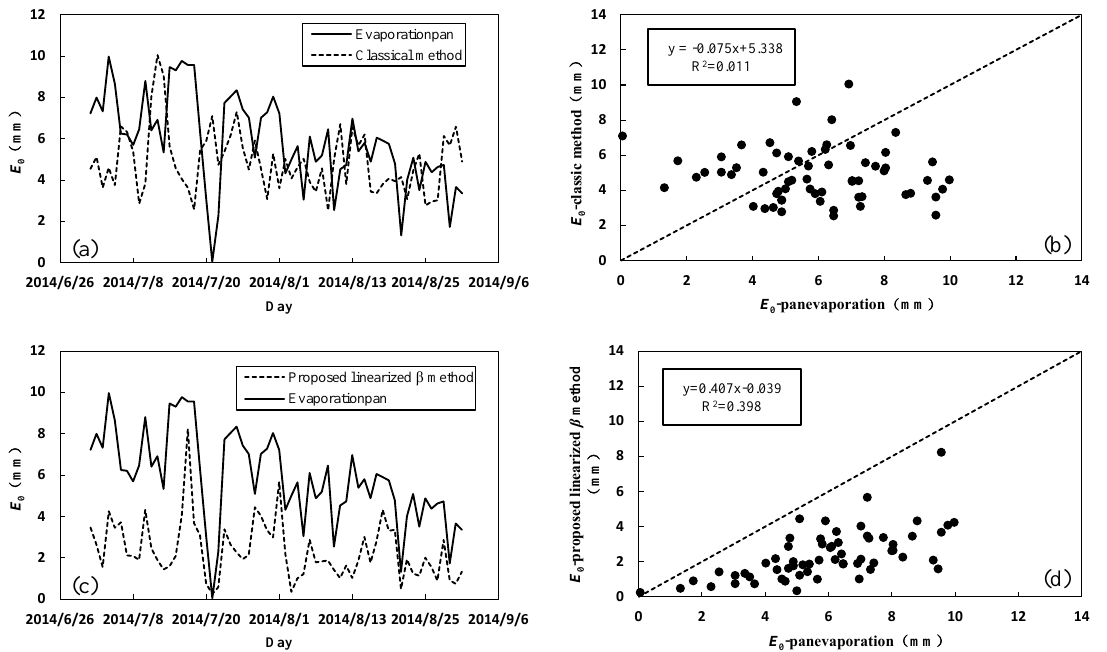
Figure 2. Dynamic variation (a, c) and comparison (b, d) between the estimated evaporation by scintillometer using the classical method and the proposed linearized β method and observed results by evaporationpan at daily time during 1 July–31 August in 2014.